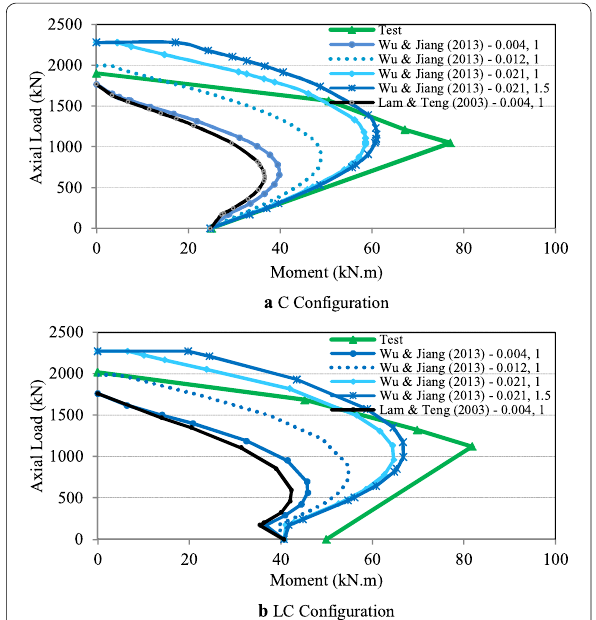
Fig. 11 Interaction diagrams for FRP‑ jacketed columns obtained using Wu and Jiang (2013) model for effective FRP strains of 0.004, 0.012 and 0.021; and UASR of 1 and 1.5.